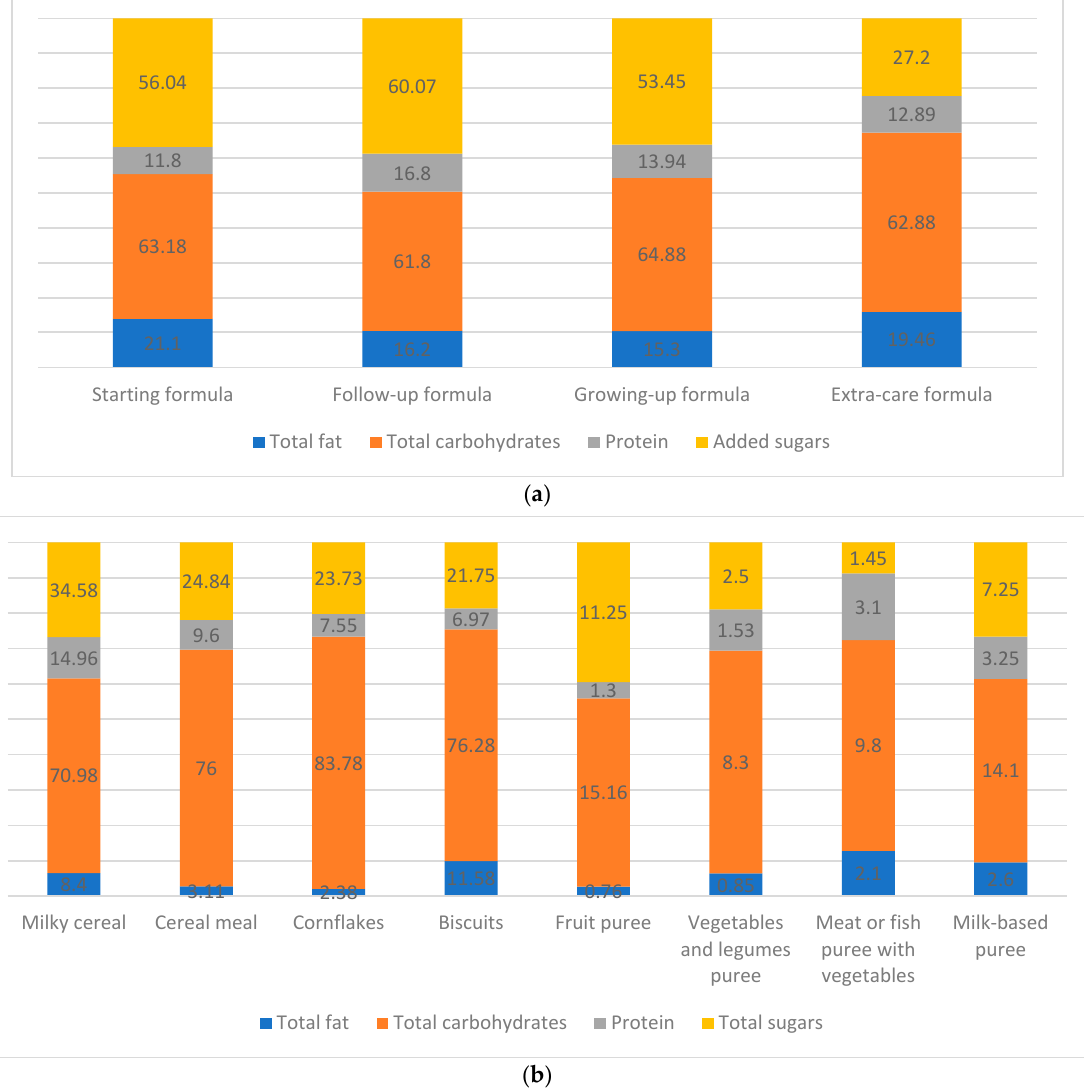
Figure 1. ( a ) Percentage of total energy, macronutrient, and added sugar distribution in 100 g of infant formula: starting formulas (0–6 months); follow-up formulas (6–12 months); growing-up formulas (1–3 years); and extra-care formulas (0–12 years). ( b ) Percentage of total energy, macronutrient, and added sugar distribution in 100 g of baby food products that targeted children aged 6 months and